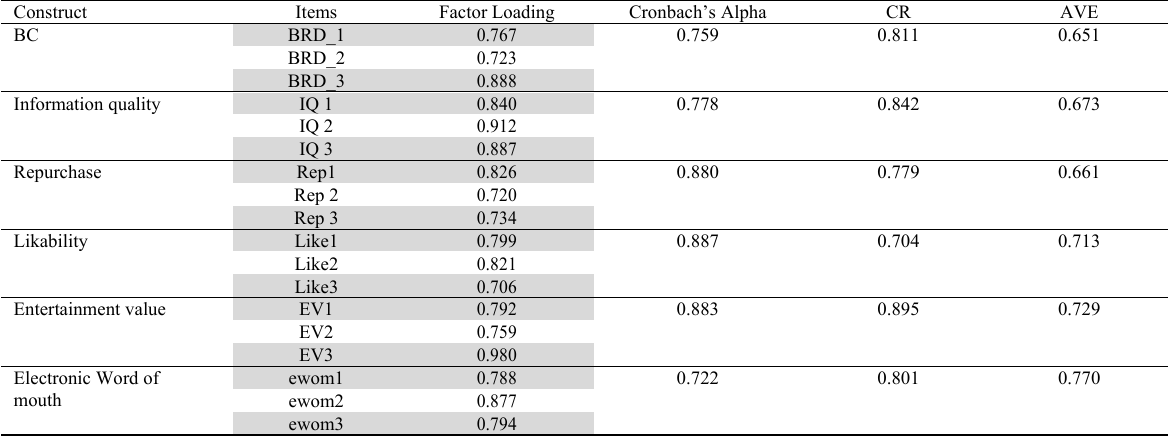
Convergent validity results